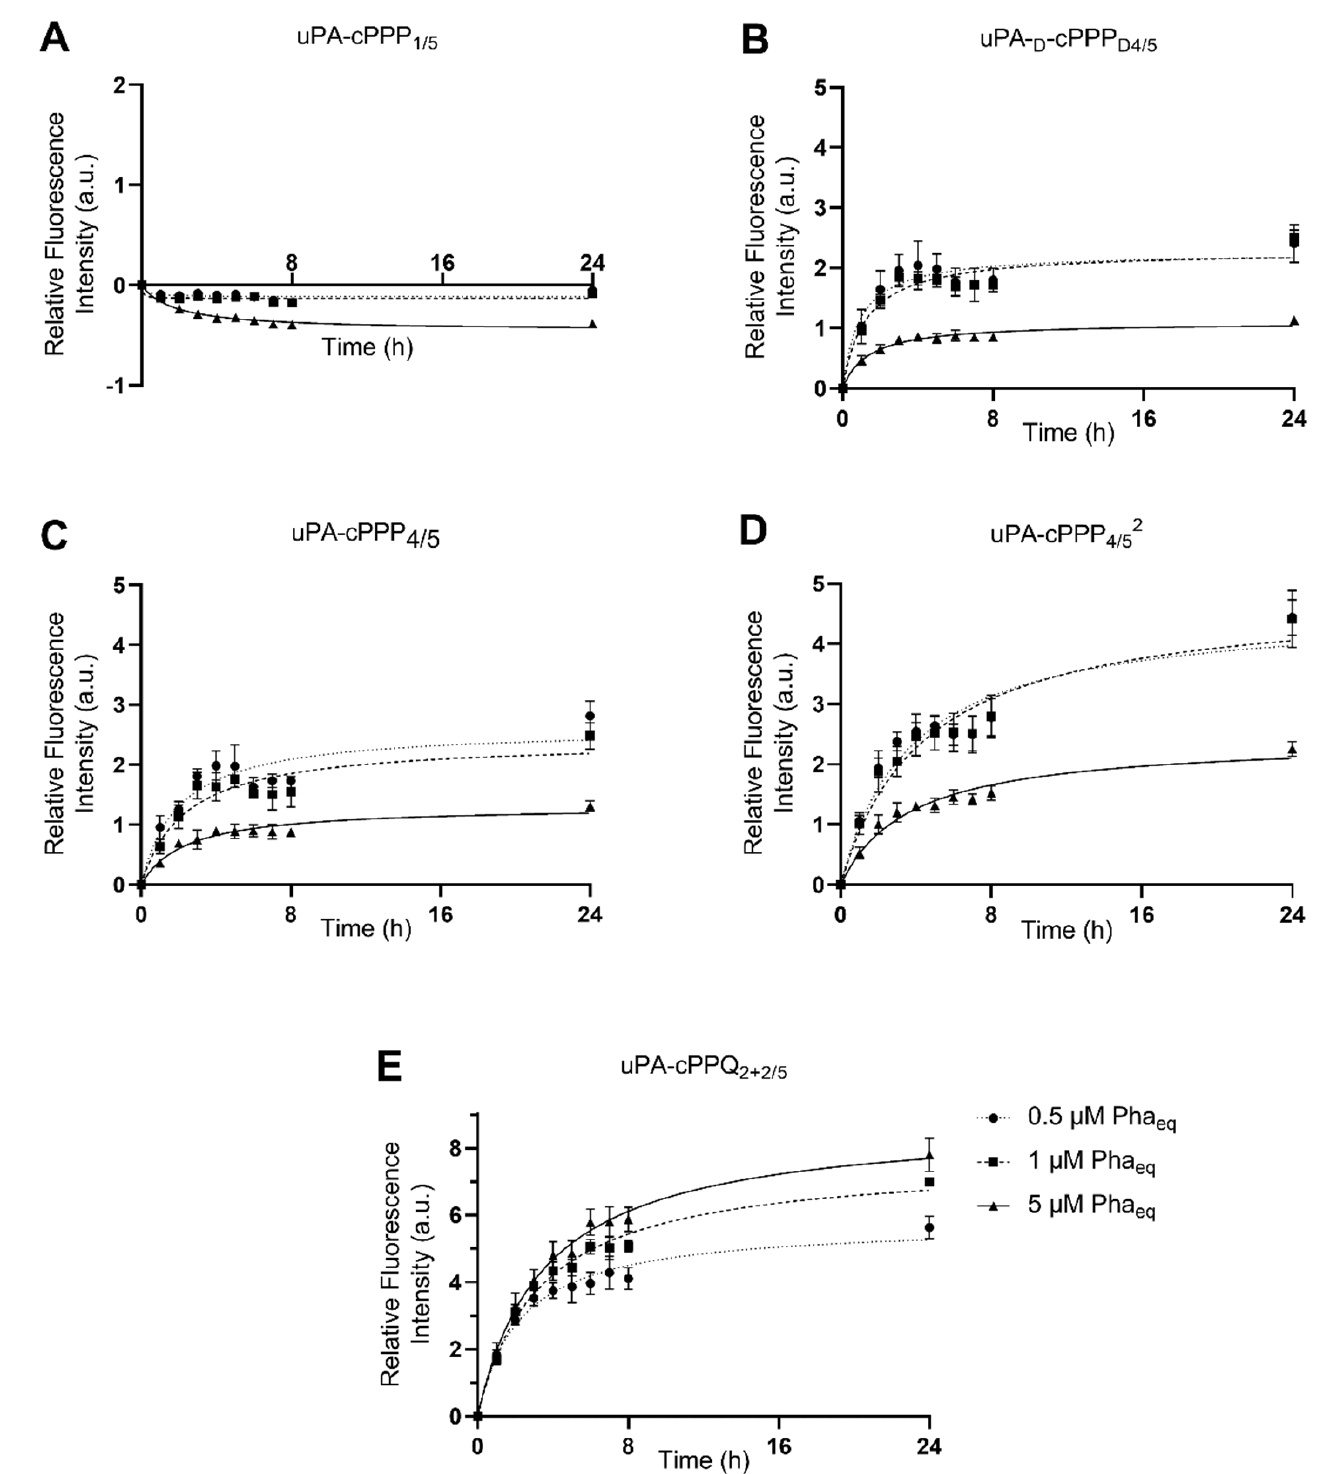
Figure 3. Red fluorescence emission of MCF7 cells upon incubation with 0.5 µM, 1 µM or 5 µM of ( A ) uPA-cPPP 1/5 , ( B ) uPA- D -cPPP D4/5 , ( C ) uPA-cPPP 4/5 , ( D ) uPA-cPPP 4/5 2 or ( E ) uPA-cPPQ 2+2/5 (n = 3 to 4; mean ± SD).